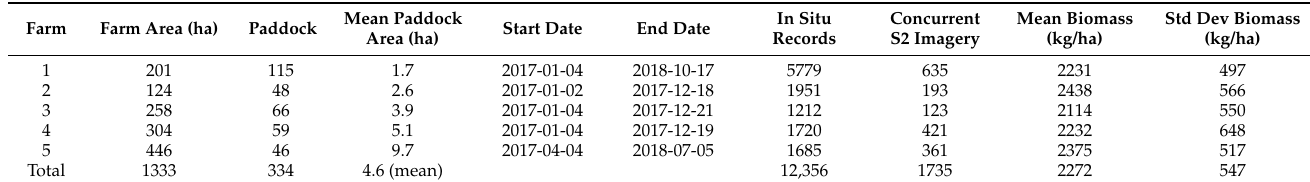
Table 2. Summary of the farm characteristics, field biomass data and satellite imagery used in this study. The imagery figures show the number of in situ records that had a cloud-free S2 overpass within one day of the biomass measurement. Farm Farm Area